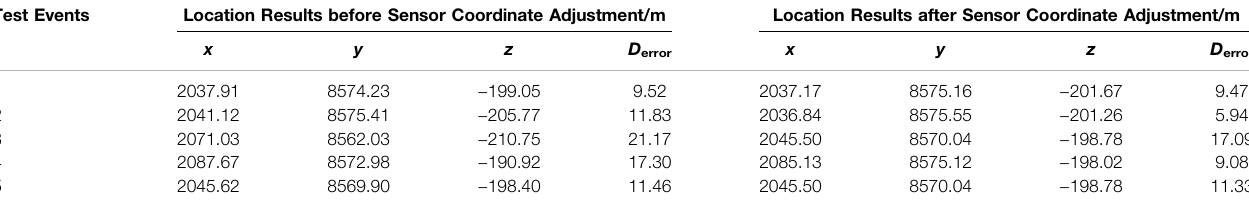
TABLE 6 | Comparison of location results before and after sensor coordinate